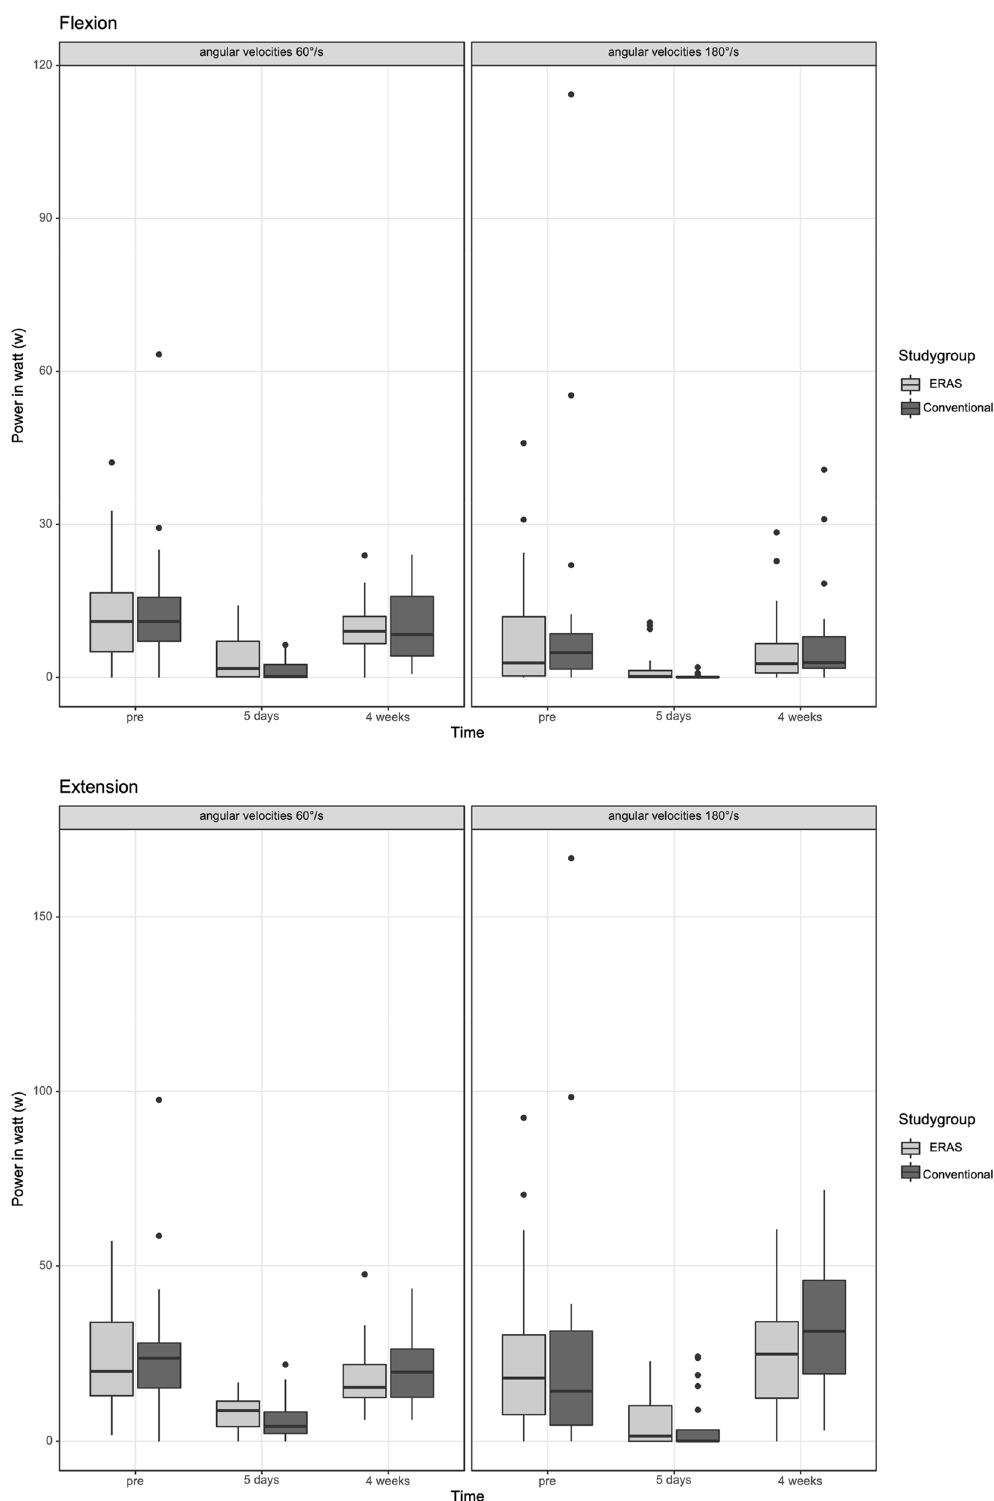
Fig. 4 a and b The flexion ( a ) and extension ( b ) power achieved for the two angular velocities measured (180°/s and 60°/s). The x-axis corresponds to the enhanced recovery after surgery (ERAS) to conventional setup preoperative and 4 weeks postoperative. The y-axis corresponds to the power in watt